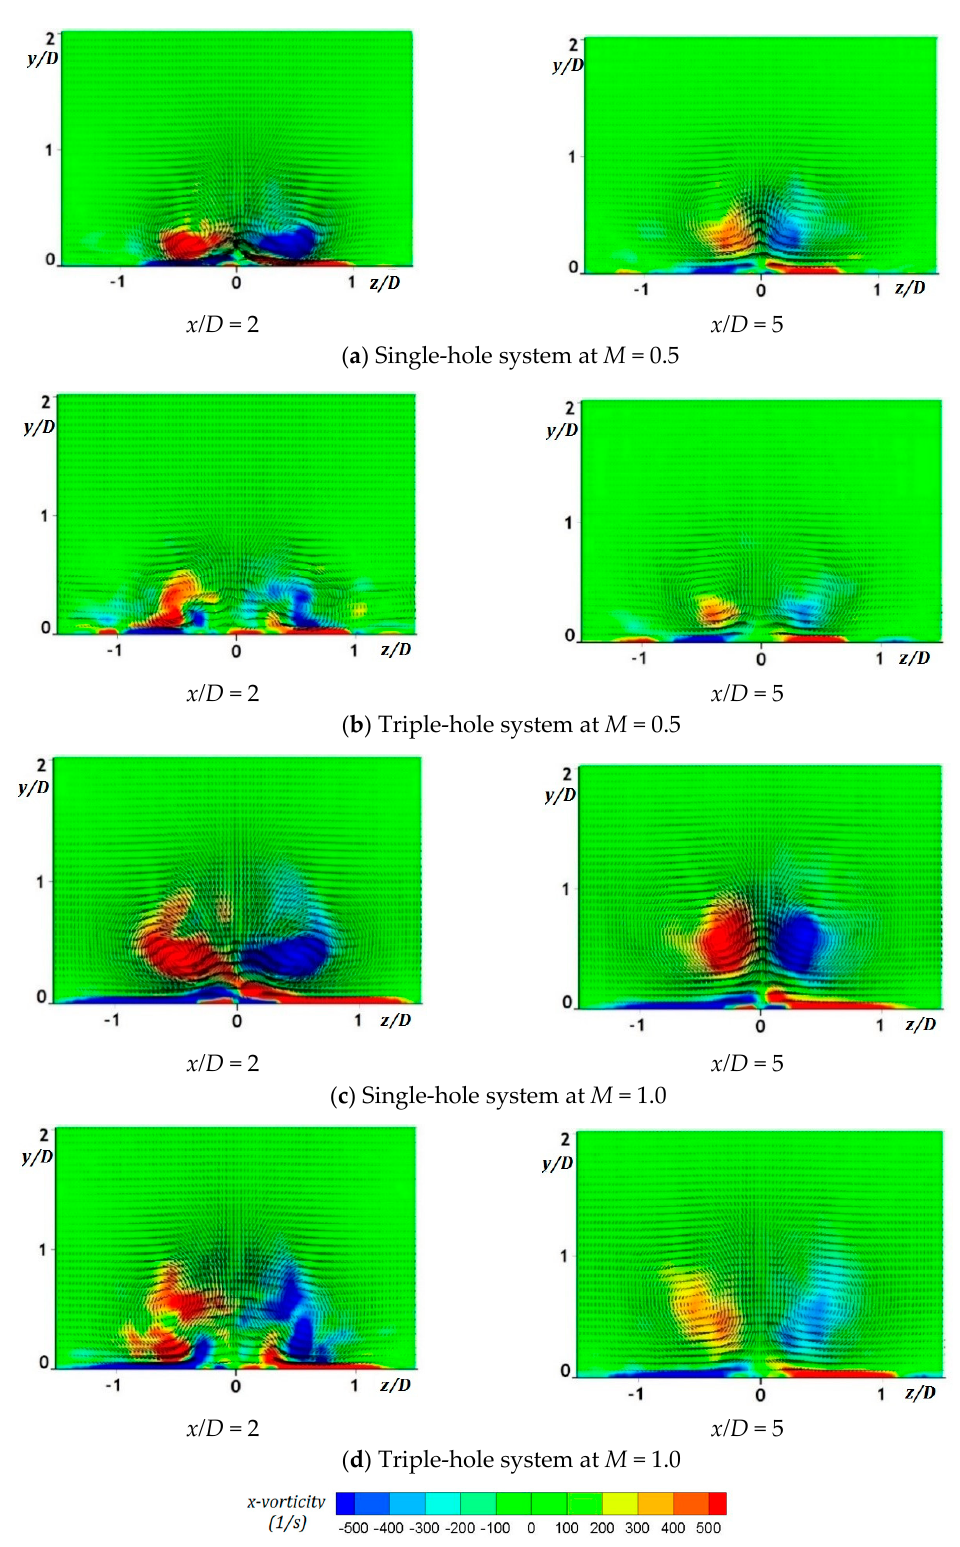
Figure 15. Cross-sectional contours of the x -vorticity and velocity vectors.